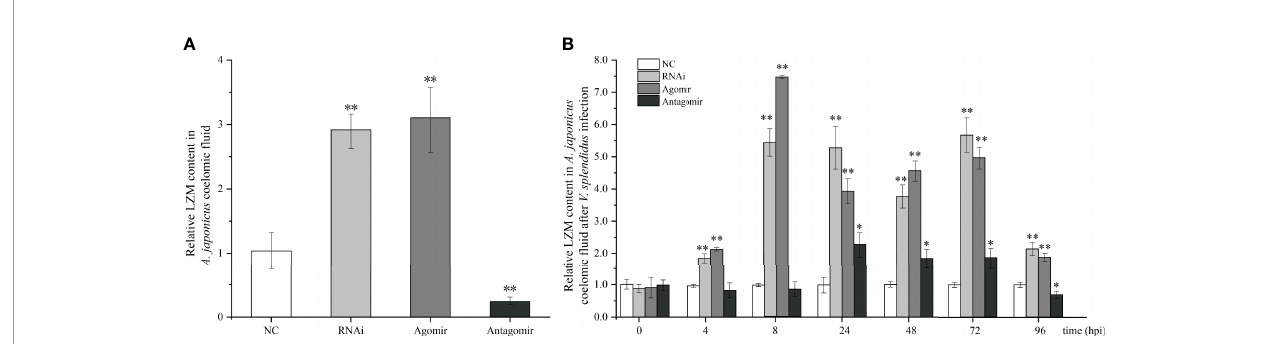
FIGURE 5 | Effects of miR-7 and AjPAK1 on relative lysozyme (LZM) content in coelomic fl uid of Apostichopus japonicus. (A) Relative LZM content in A. japonicus coelomic fl uid after AjPAK1 silencing, miR-7 overexpression, or miR-7 inhibition. (B) Relative LZM content in A. japonicus coelomic fl uid after AjPAK1 silencing, miR-7 overexpression, or miR-7 inhibition upon Vibrio splendidus infection. NC, negative control; Agomir, miR-7 overexpressed; Antagomir, miR-7 inhibition. ** represents an extremely signi fi cant difference compared with NC ( P < 0.01); * represents signi fi cant difference compared with NC ( P